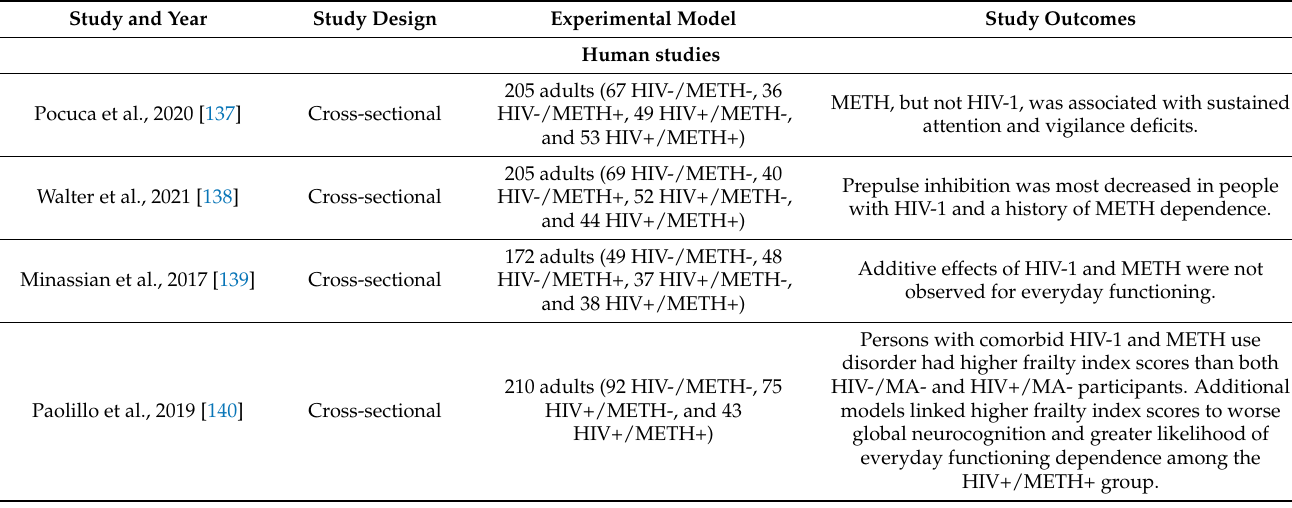
Table 2. A summary of recent studies exploring the alterations in neurocognitive functioning and behavior due to the combination of HIV-1 infection and methamphetamine (METH)